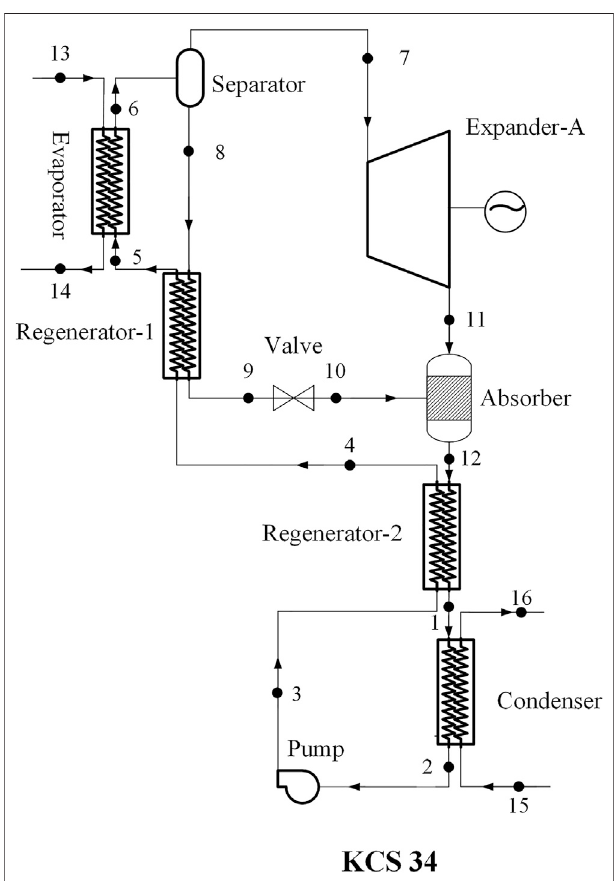
FIGURE1| TheschematicdiagramoftheoriginalKCS34(Mlack,2002).